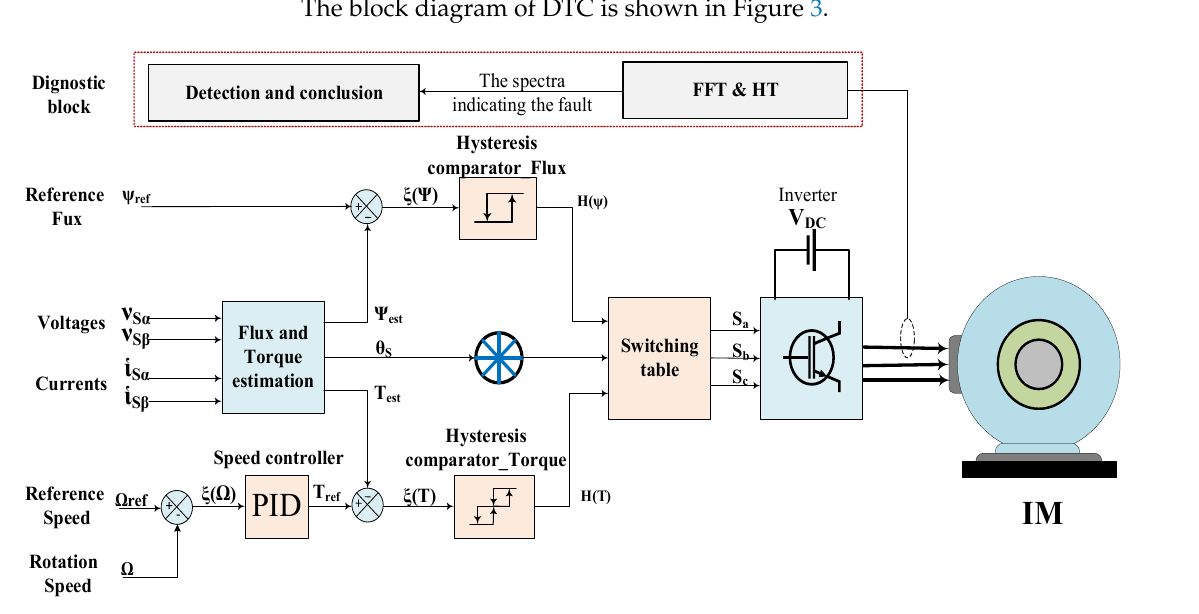
Figure 3. Classic DTC with IM and the diagnostic block .